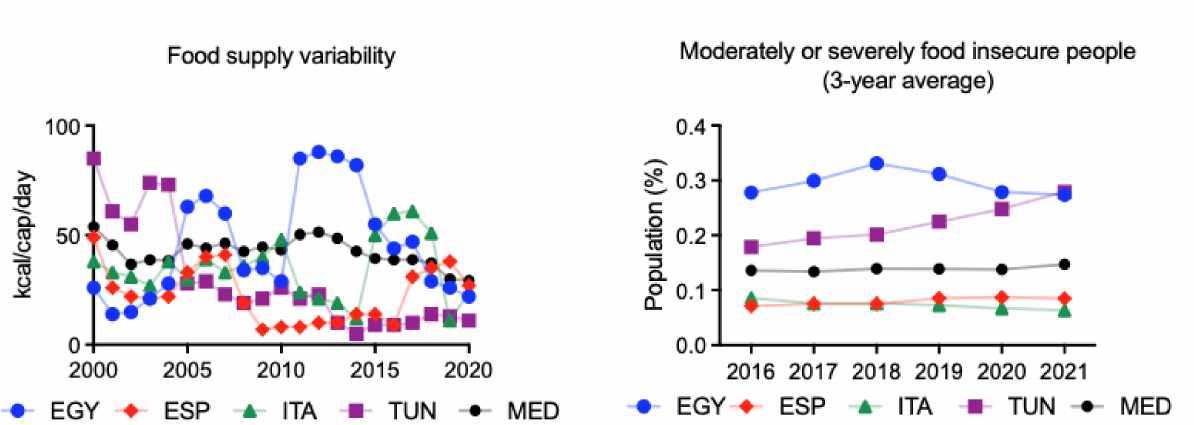
Figure 1. WEF security indicators for the years